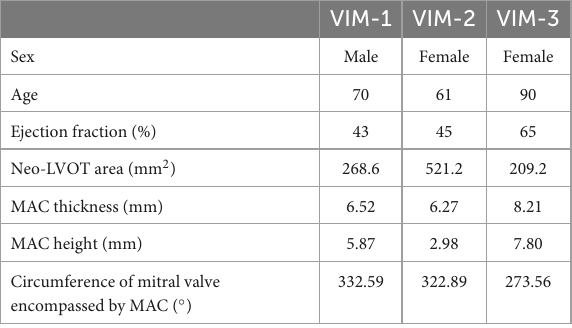
TABLE 1 Baseline resting patient